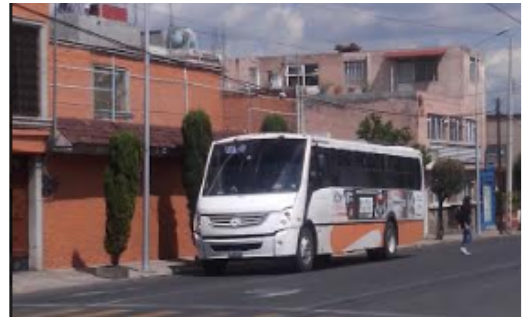
Figure 7. UDLAP Bus at one Stop.